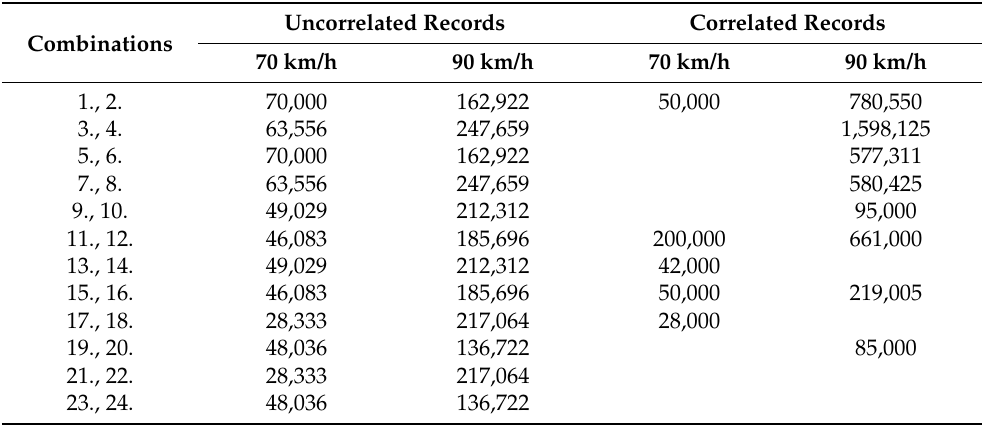
Table 13. Intercomparison of the average society-wide loss due to defect—Insufficient minimum